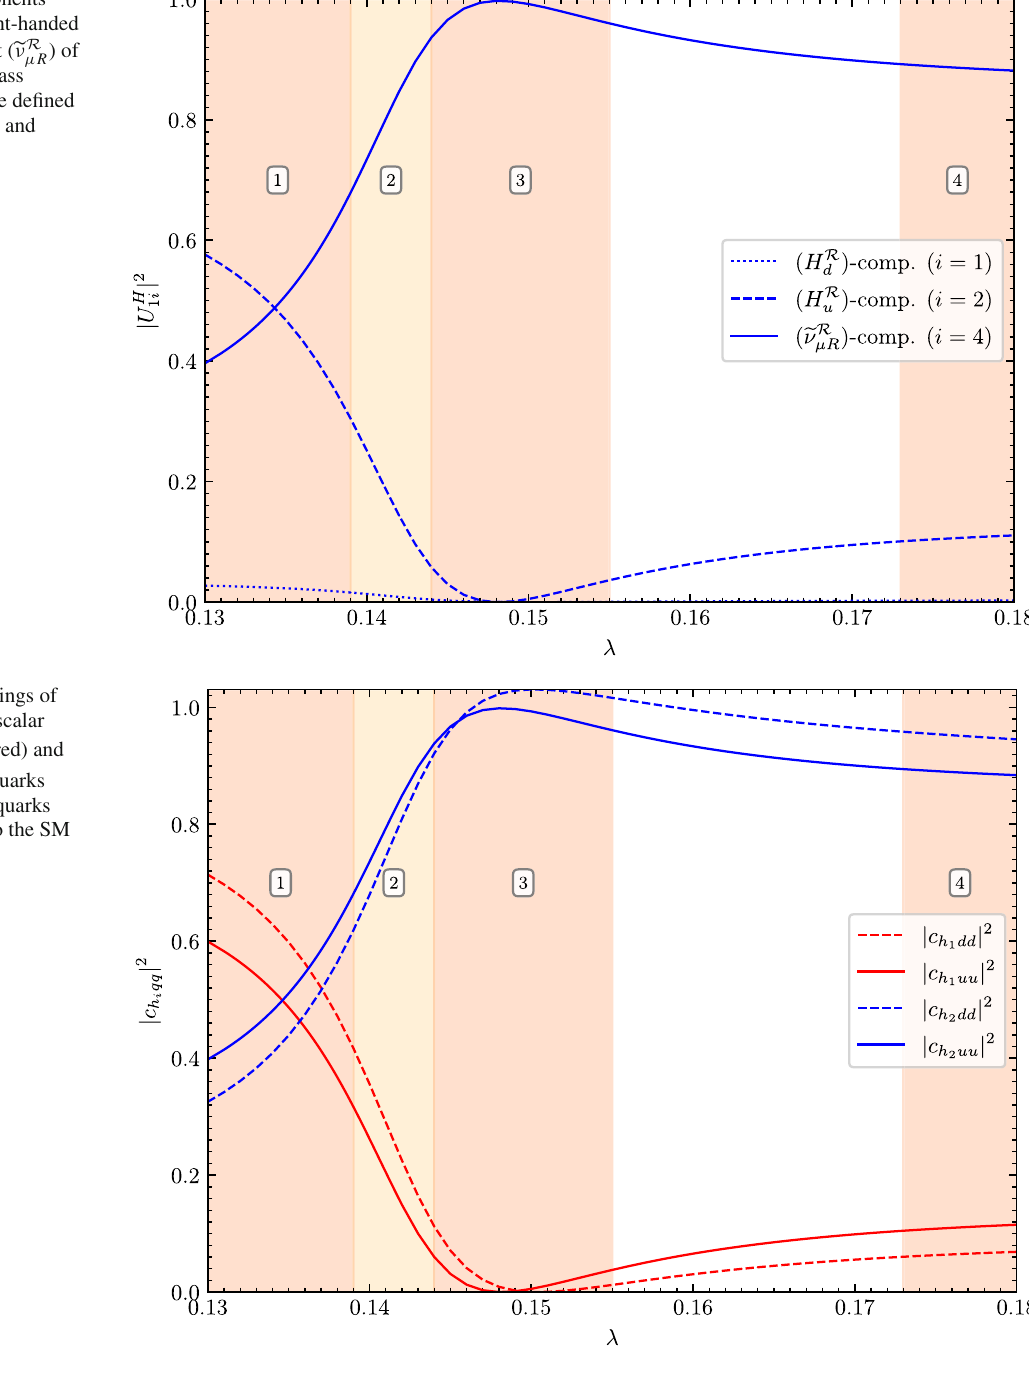
Fig. 5 Doublet components ( H R , H R u ) and the right-handed d μ -sneutrino component ( (cid:4) ν R the lightest CP -even mass eigenstate h 1 , which are defined | 2 with i = 1 , 2 and by | U H 1 i